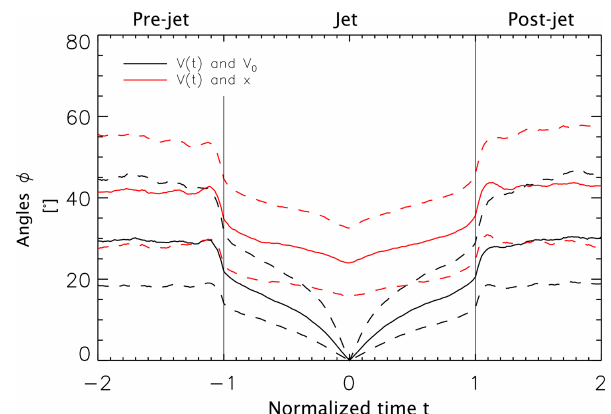
as a func- Figure 8. Superposed epoch analysis of the angle φ V , V 0 V (t) , the time series of velocity vectors, and V 0 , the vectors at times t 0 in black. In red, the superposed epoch analysis of φ V , e is shown, where e x is the unit vector in GSE x